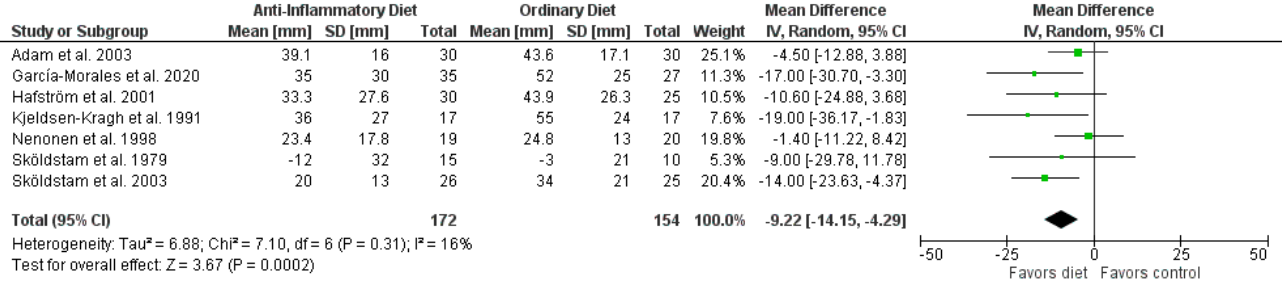
Figure 2. Forest plot summarizing the effect of anti-inflammatory diets on pain.